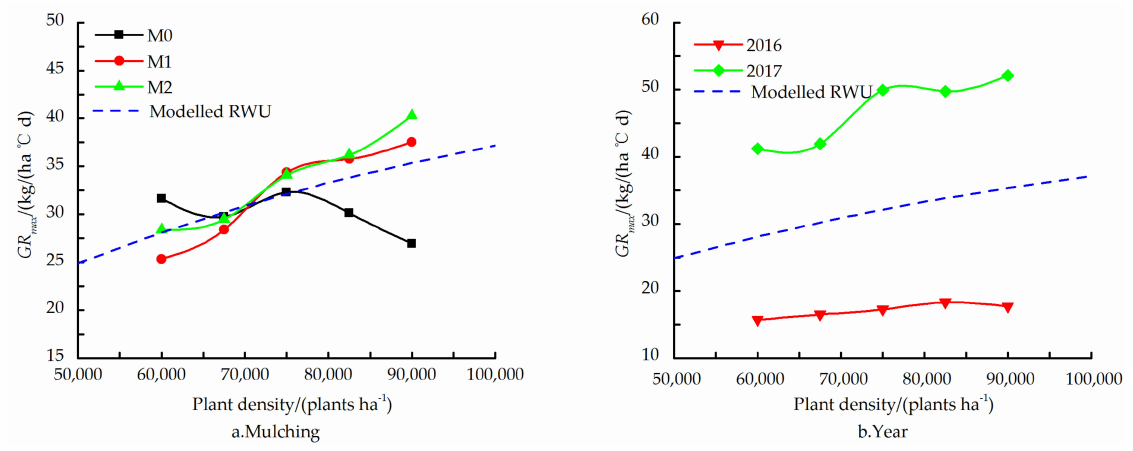
Figure 5. Maximum growth rate ( GR max ) as function of PD for no (M0), transparent (M1) and black film (M2) mulching treatment (( a ), mean of 2016 and 2017), and for the two experimental years (( b ), mean of three mulching treatments). Also shown is the GR max ( ρ ) relationship according to the fitted relative water uptake